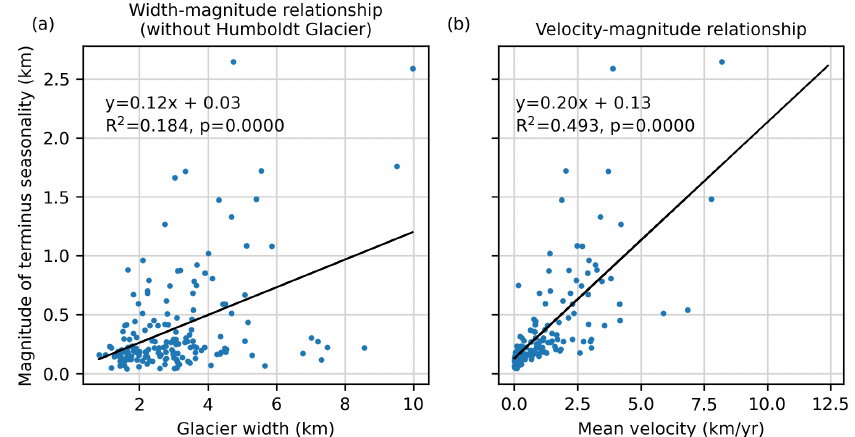
Figure 6. Relationship between the magnitude of terminus-position seasonality and (a) glacier width, with the width outlier Sermersuaq (Humboldt Glacier) removed, and (b) mean annual glacier velocity. In both subplots, the blue dots represent data for individual glaciers and the black line represents the linear regression between the two